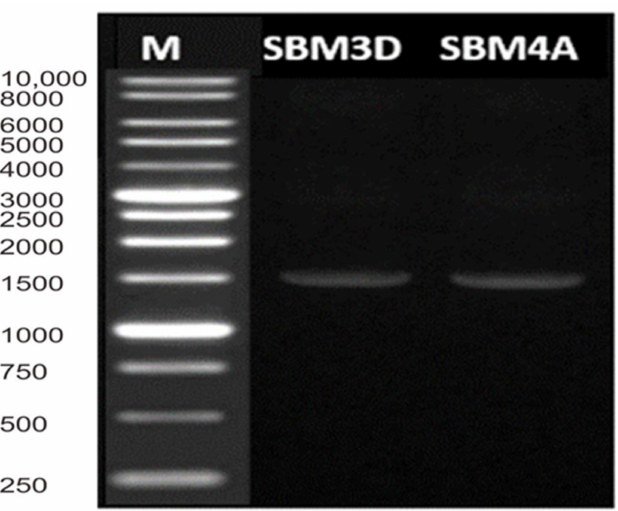
Figure 2. Multiplex-PCR amplification patterns. Lane M = DL 10,000 DNA Marker.